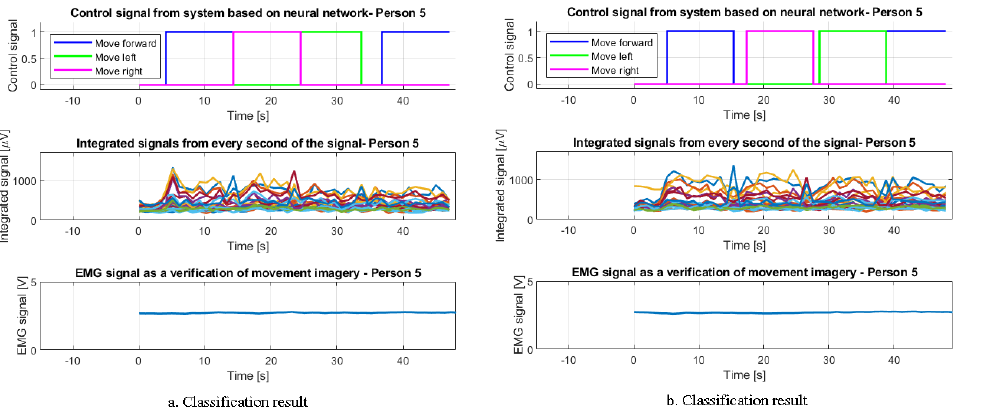
Figure 22. Observation of the signal classification and verification results—Person 5.